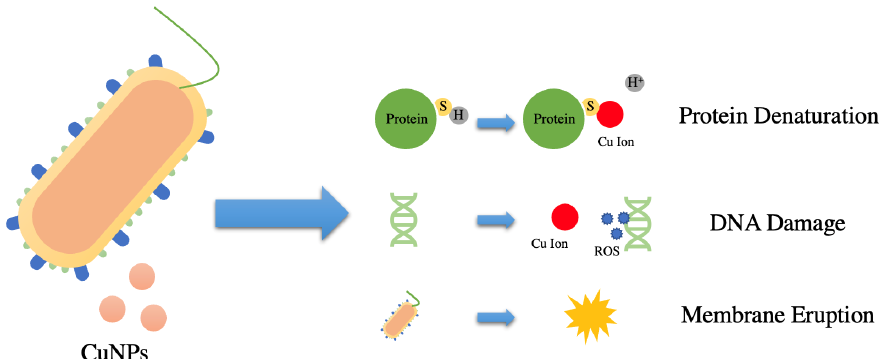
Figure 1. Schematic Diagram Demonstrating the Antibacterial Mechanism of CuNPs and Cu Ions, which Induces Protein, DNA, and Cell Membrane Damage in Bacteria Cells.